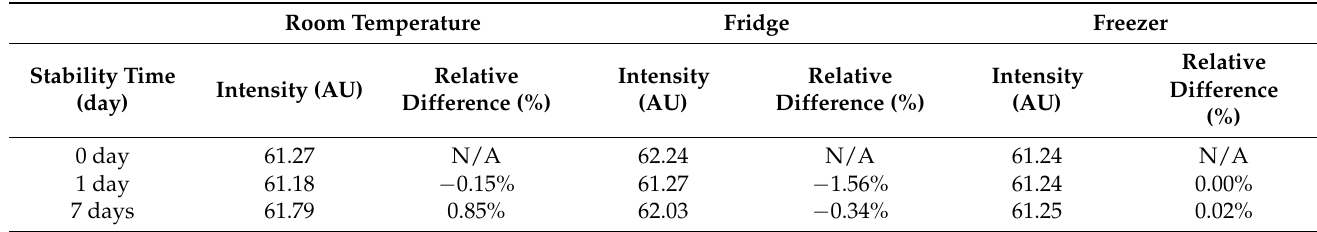
Table 12. Stability of the standard solution 0.078 µ g/mL stored at three different temperatures: room temperature, fridge, and freezer, as analyzed by fluorescence spectroscopy